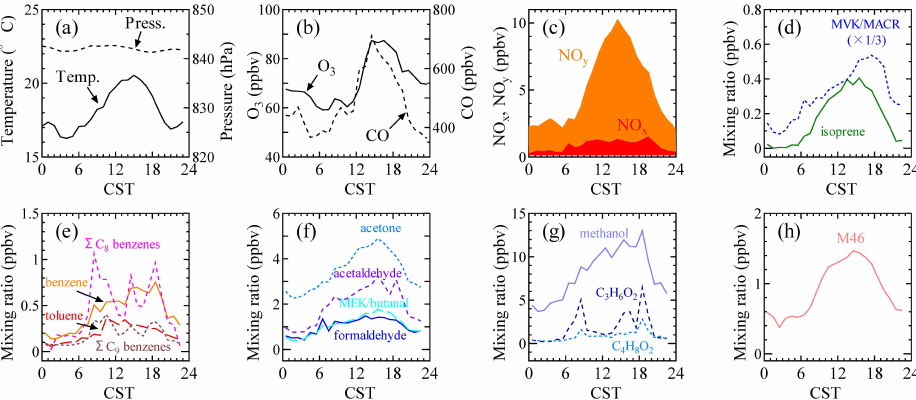
Fig. 3. Diurnal variations of temperature, atmospheric pressure, and mixing ratios of O 3 , CO, NO x , NO y , and several NMVOCs averaged during 24–28